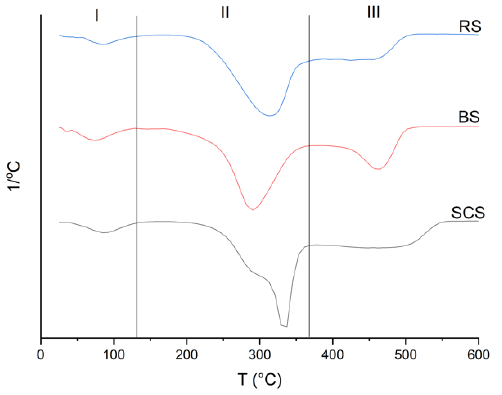
Figure 4. DTA curves of untreated RS, BS, and SCS fibers.